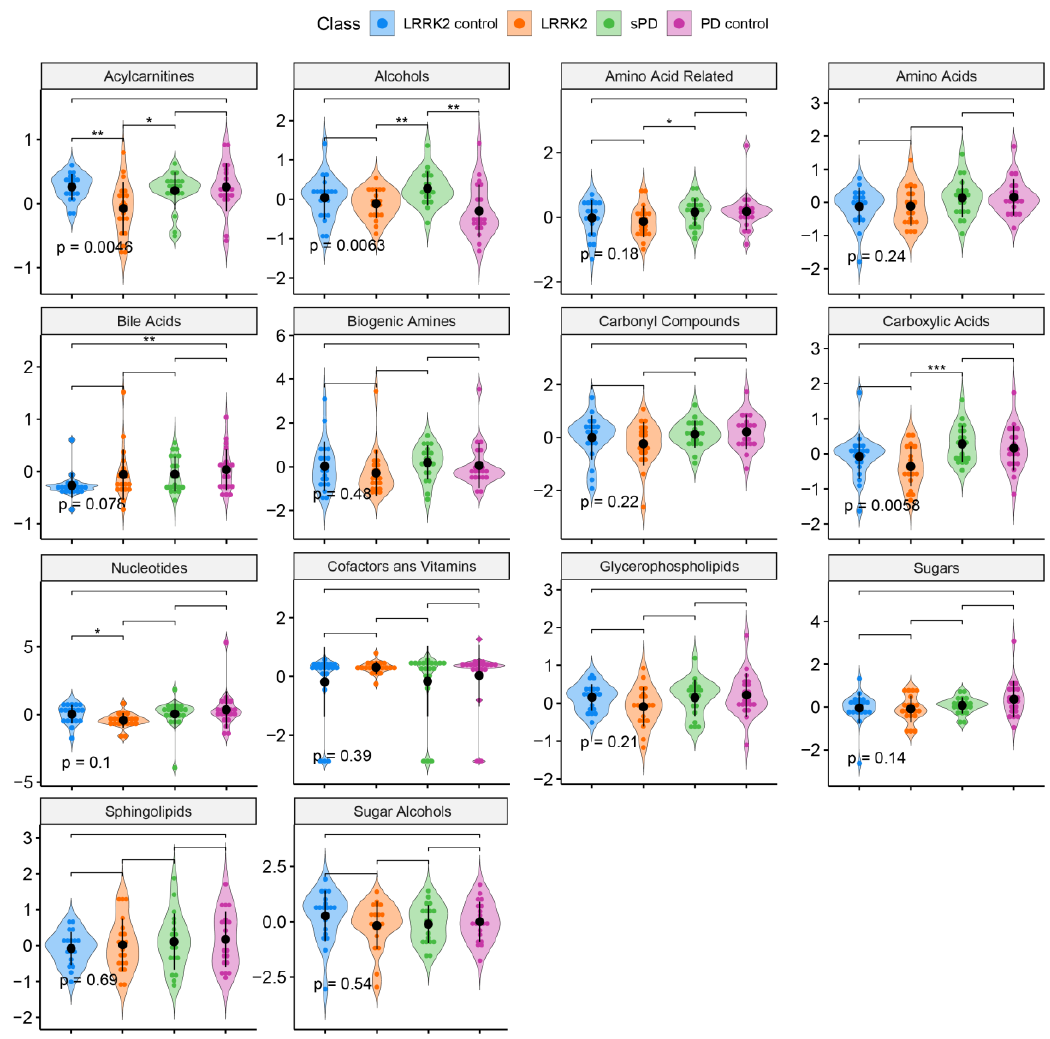
Figure 3. Violin plots comparing the median concentrations of the different metabolite species as identified in the CSF of sPD ( n = 20), sPD controls ( n = 20), LRRK2 PD ( n = 20), and LRRK2 controls ( n = 20). The data were analyzed using a Student’s t -test where ns: p > 0.05, *: p ≤ 0.05, **: p ≤ 0.01, ***: p ≤ 0.001. A point in one of the violin plots is representative of a patient sample. Each p -value shown on a plot is an ANOVA p -value for all the patient groups.